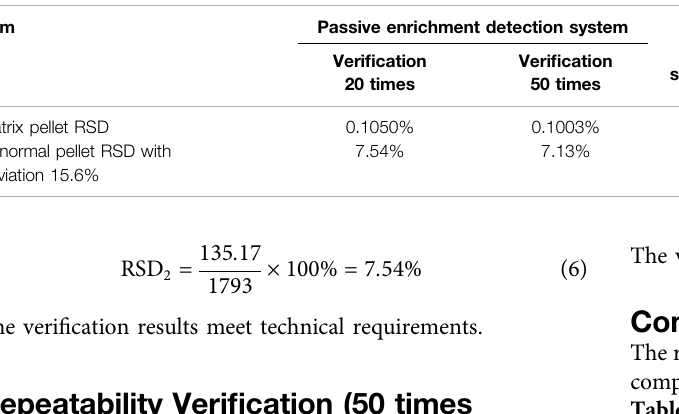
TABLE 8 | Comparison of repeatability veri fi